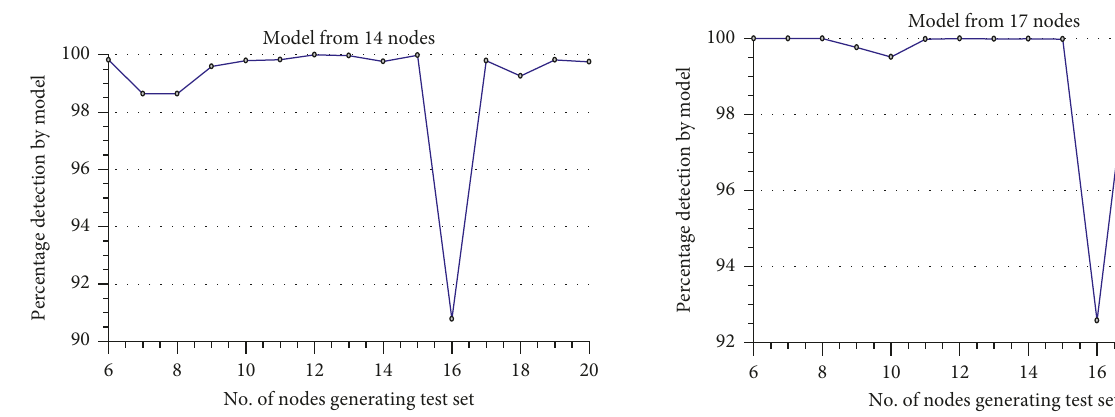
Figure 19: Simulation results for 17 nodes.